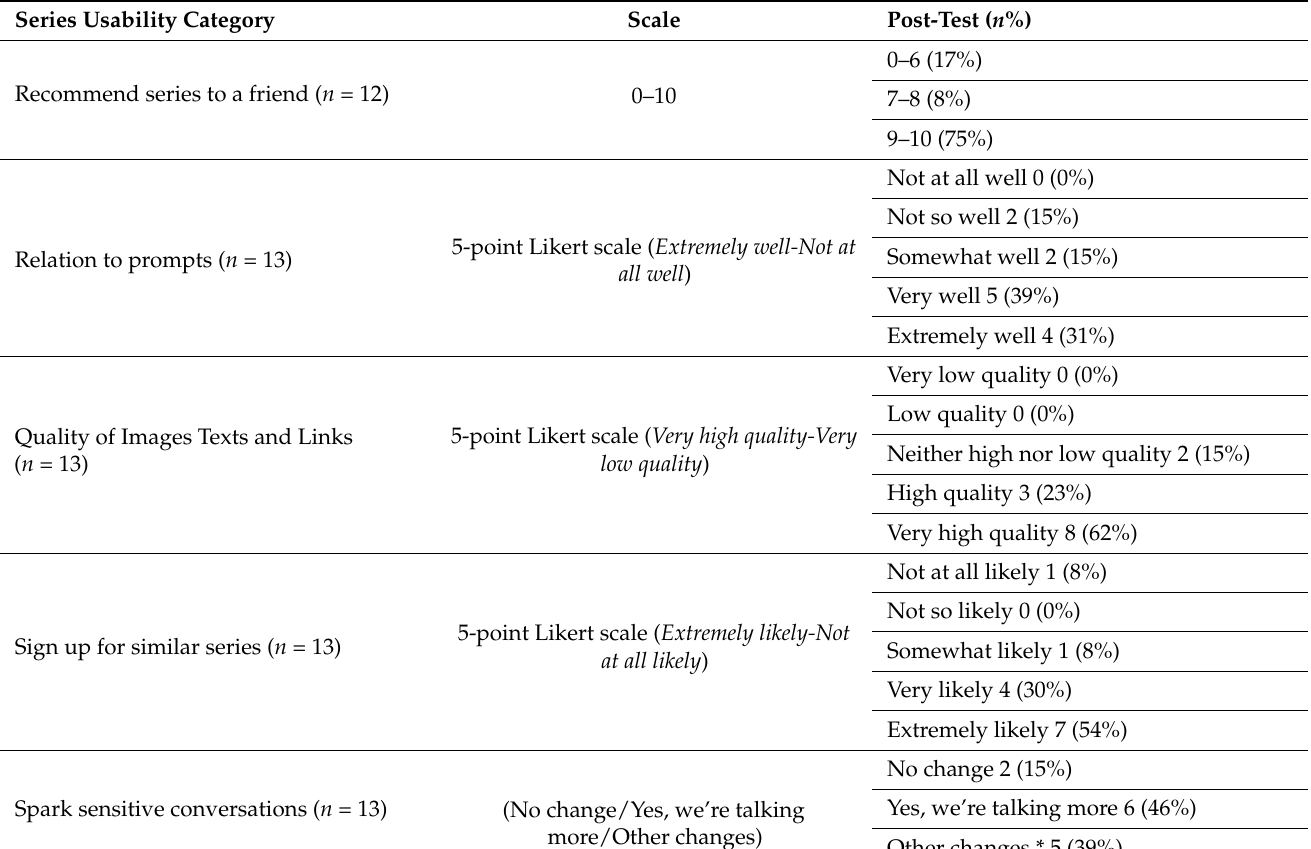
Table 3. Measures for Post-Survey Series